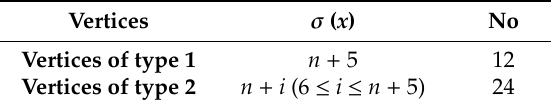
Table 1. The eccentricity of vertices of C 24 n + 12 , n ≥ 7.